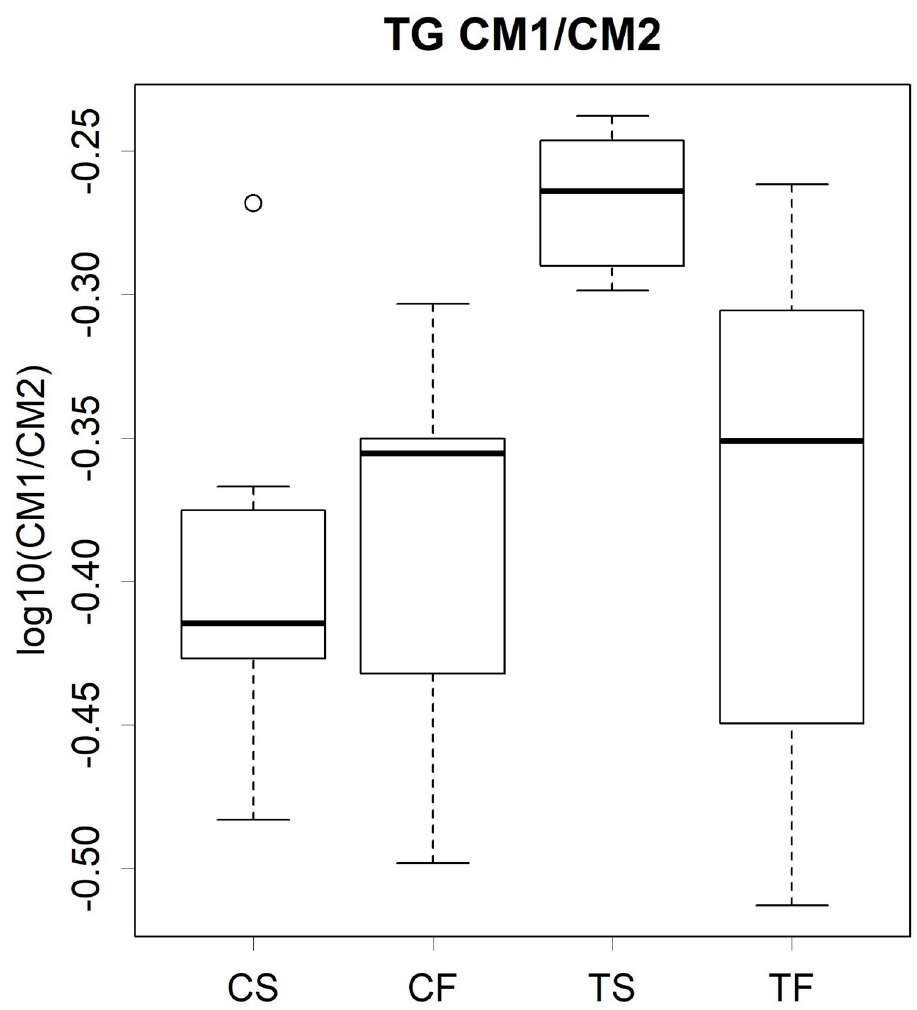
Fig 5. Ratio of CM1 to CM2 in serum TG. C, Casein; T, tofu; S, soy oil; F, fish oil. The bottom and top of the box are the first and third quartiles, respectively, and the band inside the box indicates the second quartile. Small circles show outliers. Results of statistical analyses are presented in S1